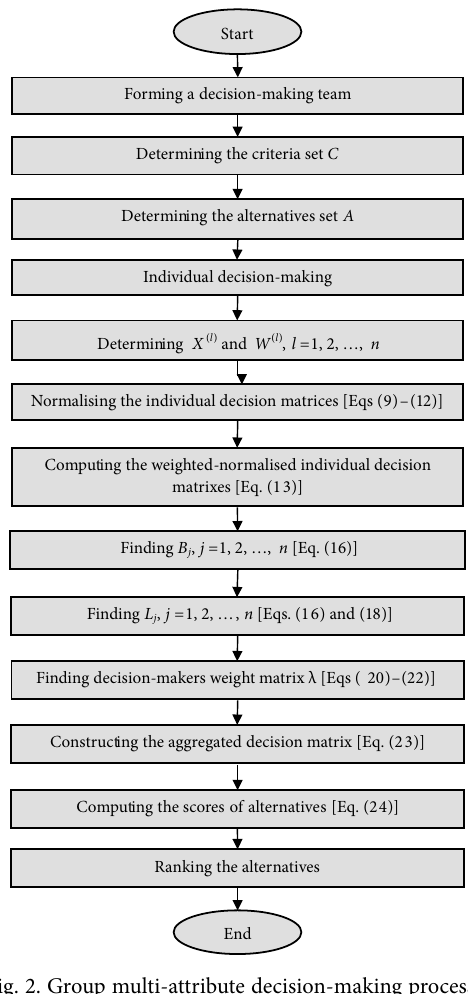
Fig. 2. Group multi-attribute decision-making